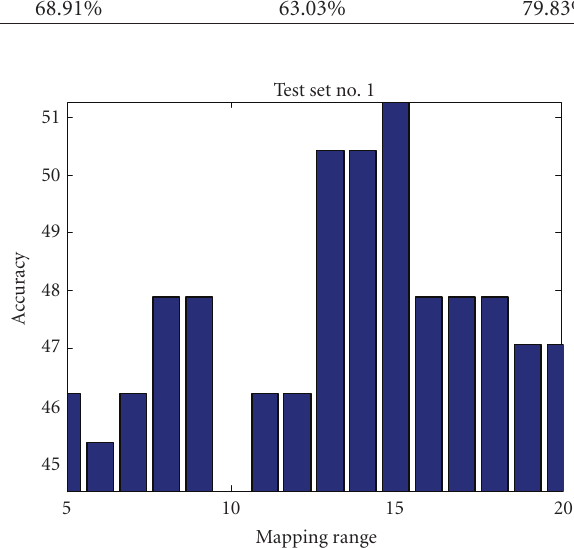
Figure 9: Mapping range impact on algorithm accuracy for test set no.